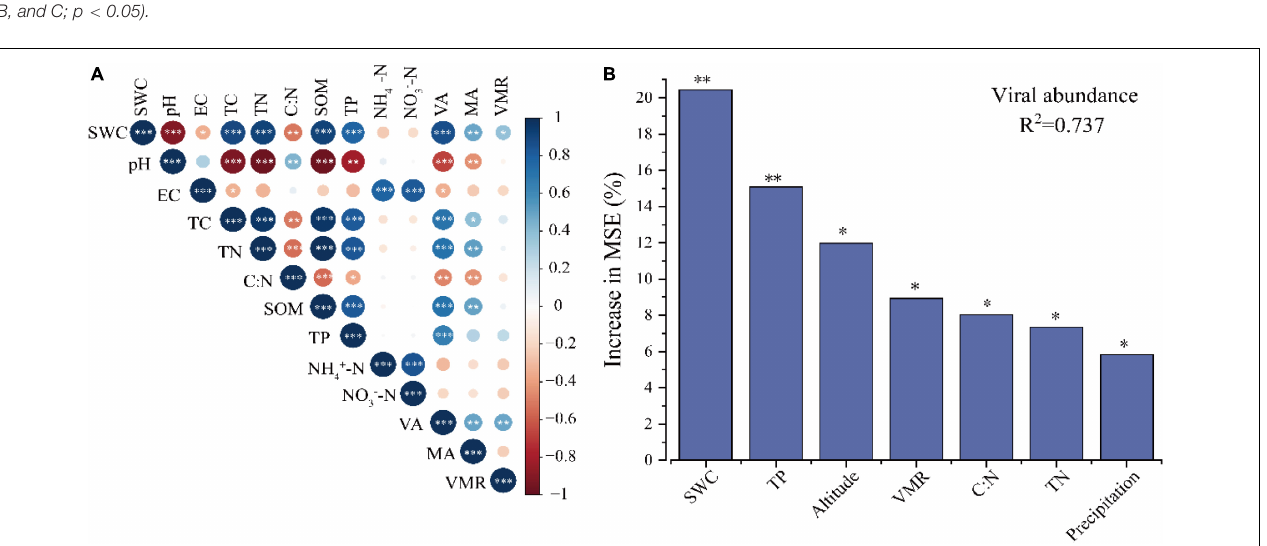
Frontiers in Microbiology |